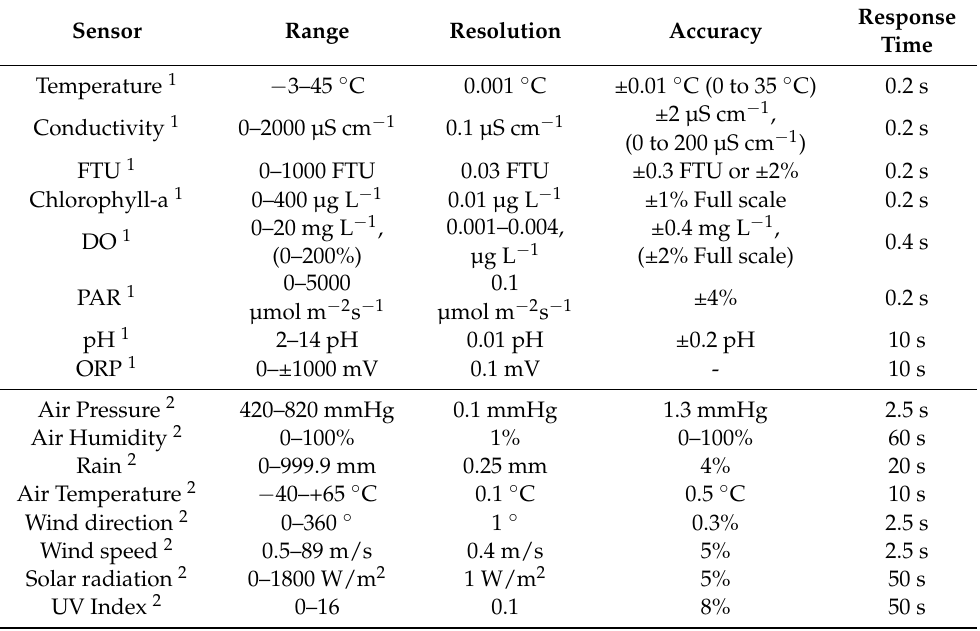
Table 1. Accuracy and resolution of measured parameters of AHMS (parameters are marked with the following indices: 1—JFE Advantech, 2—Davis